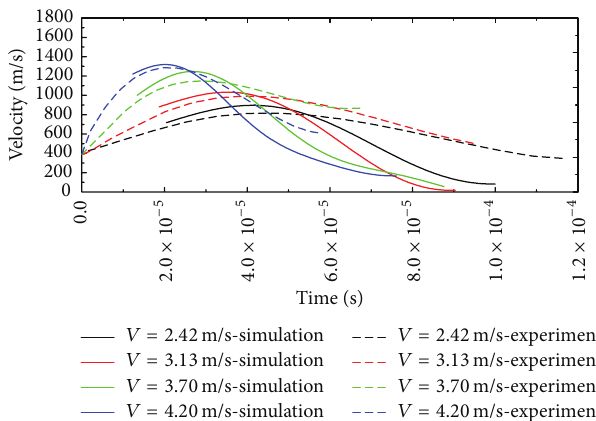
Figure 5: Quantitative verification: comparison of crack propaga- tion velocities between simulation results and experimental